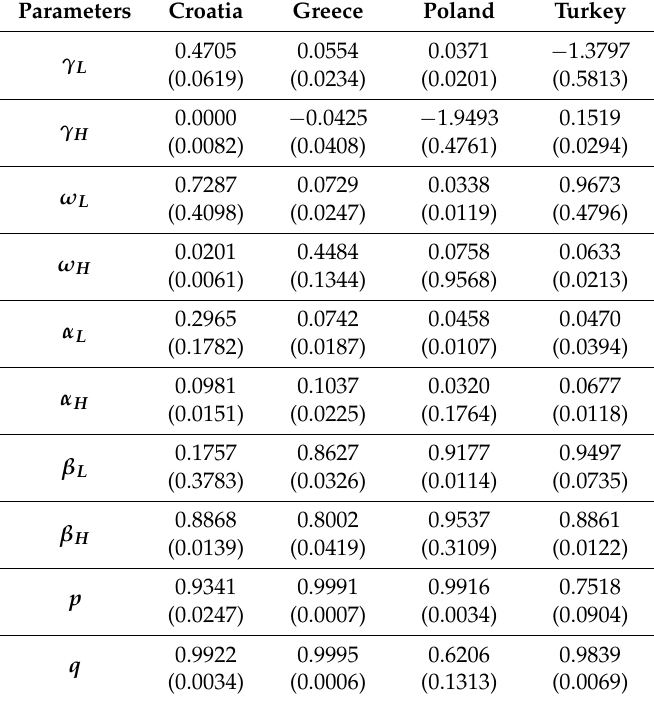
Table 7. MRS-GARCH parameters of the log returns of the original